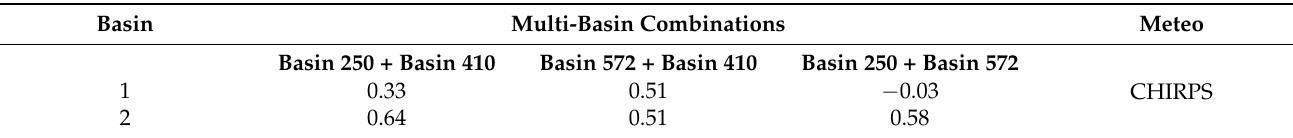
Table 4. Optimized mHM results (KGE) from multi-basin combinations. Basin